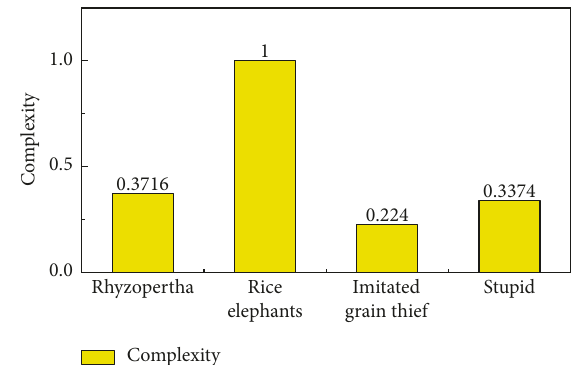
Figure 4: Normalized eigenvalues (complexity) of identified